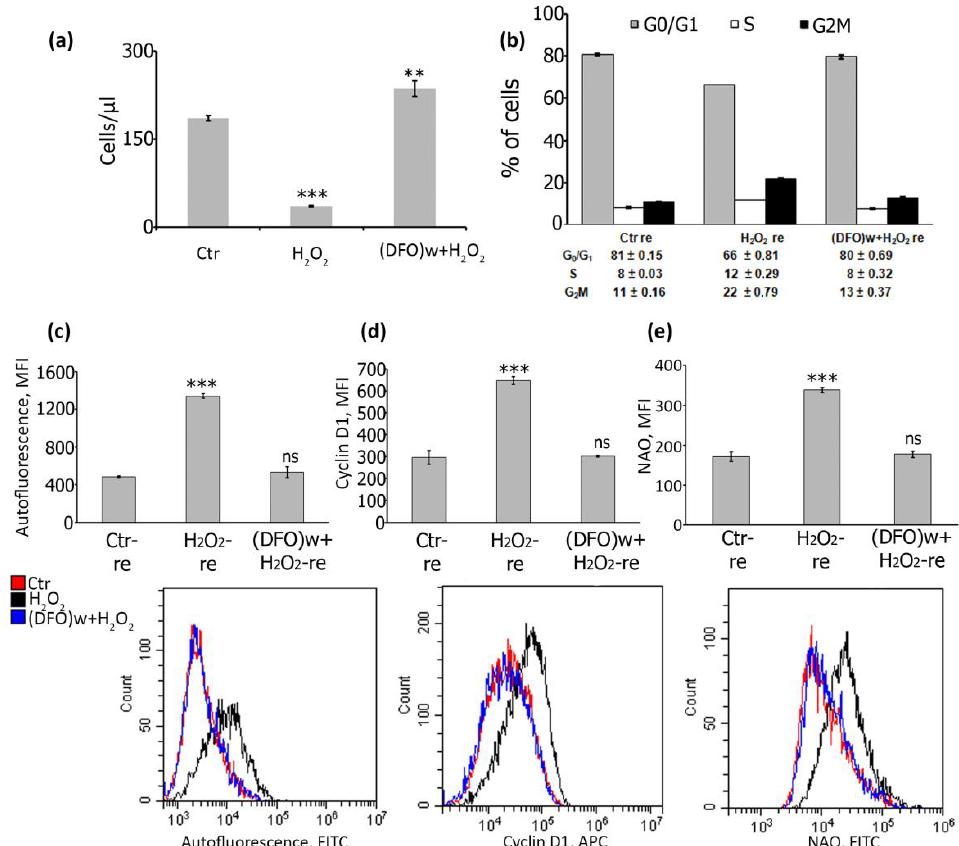
Figure 3. The protective effect of the single-dose DFO pretreatment against H 2 O 2 -induced senescence is preserved after cell reseeding. ( a ) The number of viable PI-negative cells determined in untreated, H 2 O 2 -treated and DFO-pretreated-hMESCs after reseeding. ( b ) Cell cycle distribution of the same cells. ( c – e ) FACS analysis of the senescence markers after cell reseeding: lipofuscin ( c ), cyclin D1 ( d ), mitochondrial mass as nonyl acridine orange (NAO) fluorescence ( e ) (histograms (top line) and the appropriate representative distributions (bottom line)). Data are shown as Mean ± SD, n = 3, *** p < 0.005, ** p < 0.01.